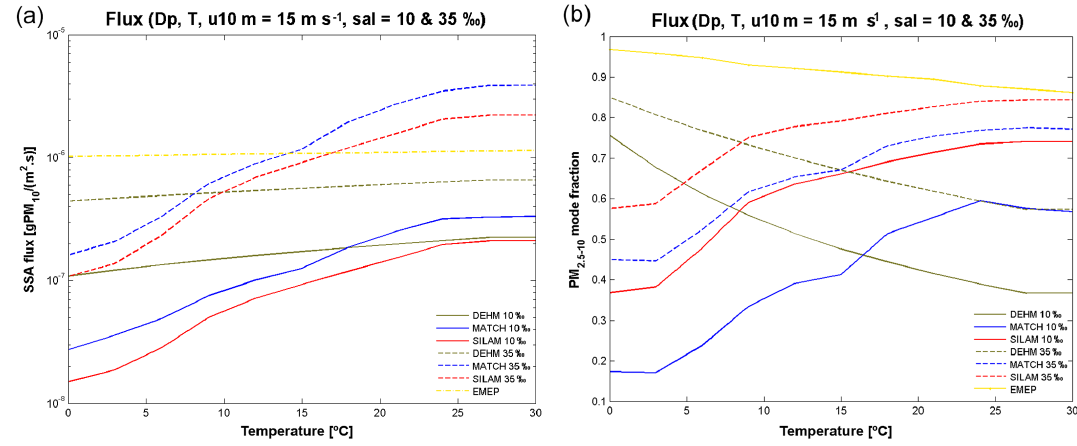
Figure 9. SSA mass flux (gPM 10 m − 2 s − 1 ) box calculations (a) and coarse mode fraction of the mass flux (b) : as a function of radius (dry for DEHM and SILAM and RH = 80% for MATCH) and temperature, for wind speed 15ms − 1 and salinities 10 and